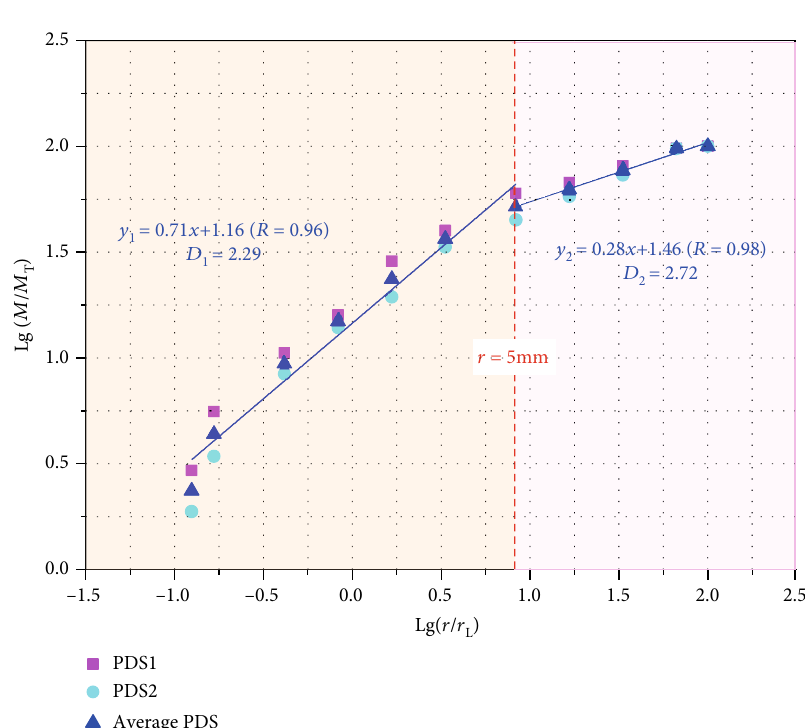
Figure 4: Calculation of the fractal dimension of the grain size of clay gravel and its